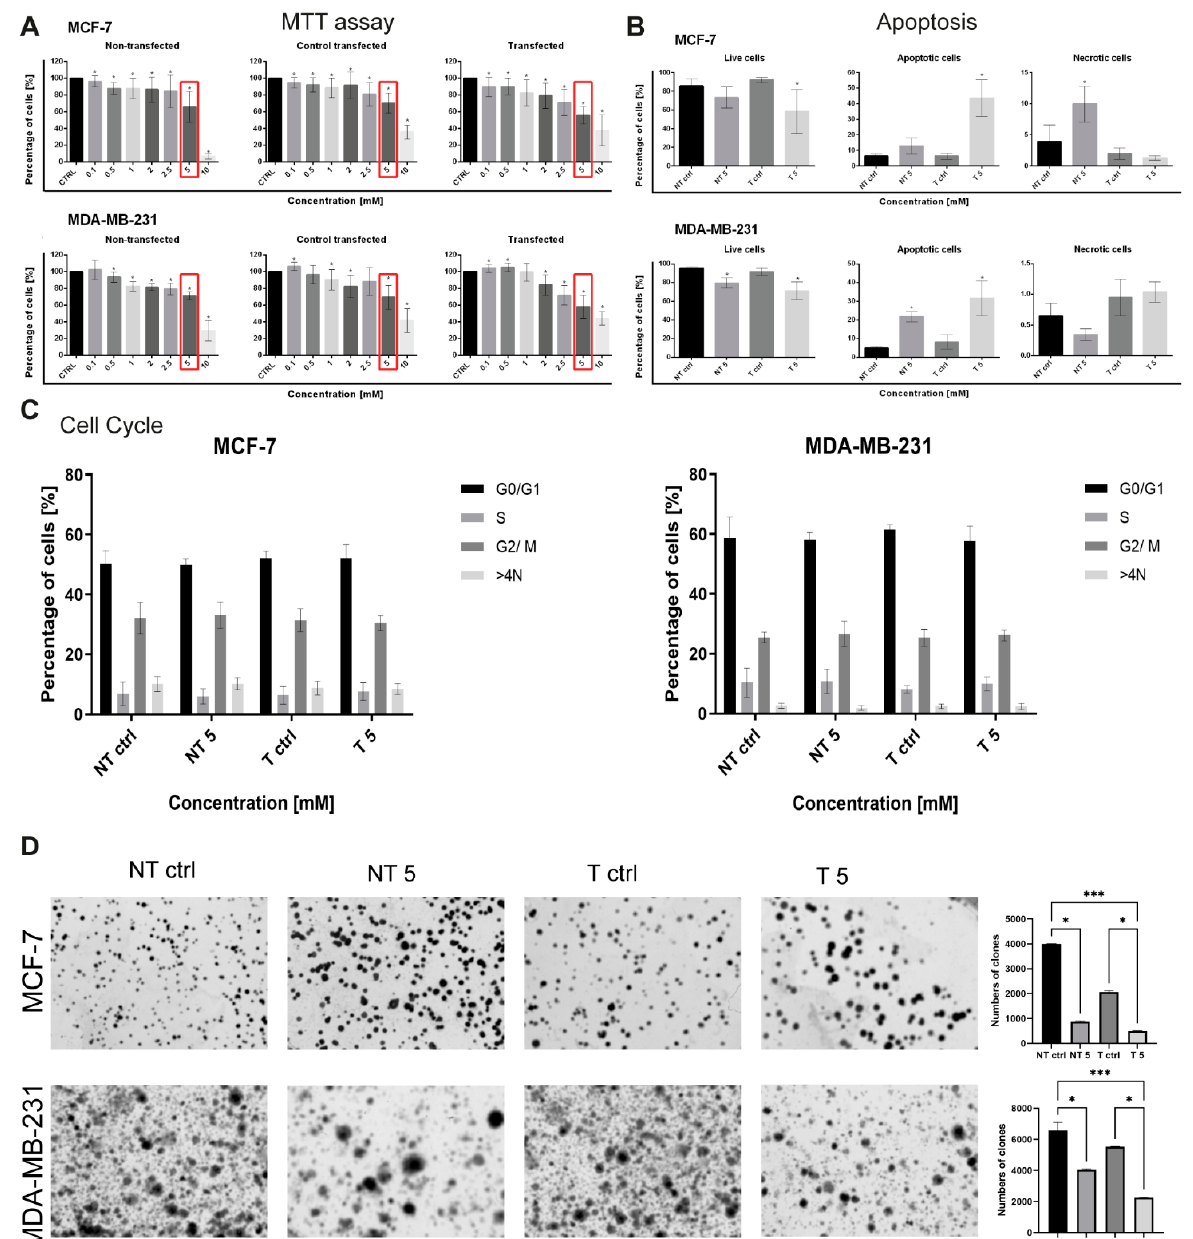
Figure 3. ( A ) The cell viability analysis was based on the MTT assay. The analysis included non-transfected, transfected with control siRNA, and transfected with MMP-9 siRNA cells treated with cyclophosphamide at 0.1–10 mM concentrations for 24 h. The data represent mean values ± SD of 4 independent experiments ( n = 4). Statistically significant differences were marked with ‘*’ ( p < 0.05; Wilcoxon test). ( B ) The cell death analysis was based on AnnexinV/PI staining. NT—non-transfected cells, T—cells transfected with MMP-9 siRNA, NT5 and T5 non-transfected and transfected cells treated with 5 mM cyclophosphamide for 24 h. Data represent the mean ± SD obtained from 4 independent replicates ( n = 4). Statistically significant differences are marked with ‘*’ ( p < 0.05; Kruskal–Wallis test with Dunn’s multiple comparisons test). ( C ) The cell cycle analysis of MCF-7 and MDA-MB-231cells. NT—non-transfected cells, T—cells transfected with MMP-9 siRNA, NT5 and T5 non-transfected and transfected cells treated with 5 mM cyclophosphamide for 24 h. Data represent the mean ± SD obtained from 4 independent replicates ( n = 4, statistical Two-way ANOVA test). ( D ) The effect of MMP-9 downregulation on colonies formed of breast cancer cell lines. NT—non-transfected cells, T—cells transfected with MMP-9 siRNA, NT5 and T5 non-transfected and transfected cells treated with 5 mM cyclophosphamide for 24 h. Representative image of clonogenic assay and the number of colonies formed. Statistically significant differences were marked with ‘*’ p ≤ 0.05, ‘***’ p ≤ 0.001 (Kruskal-Wallis